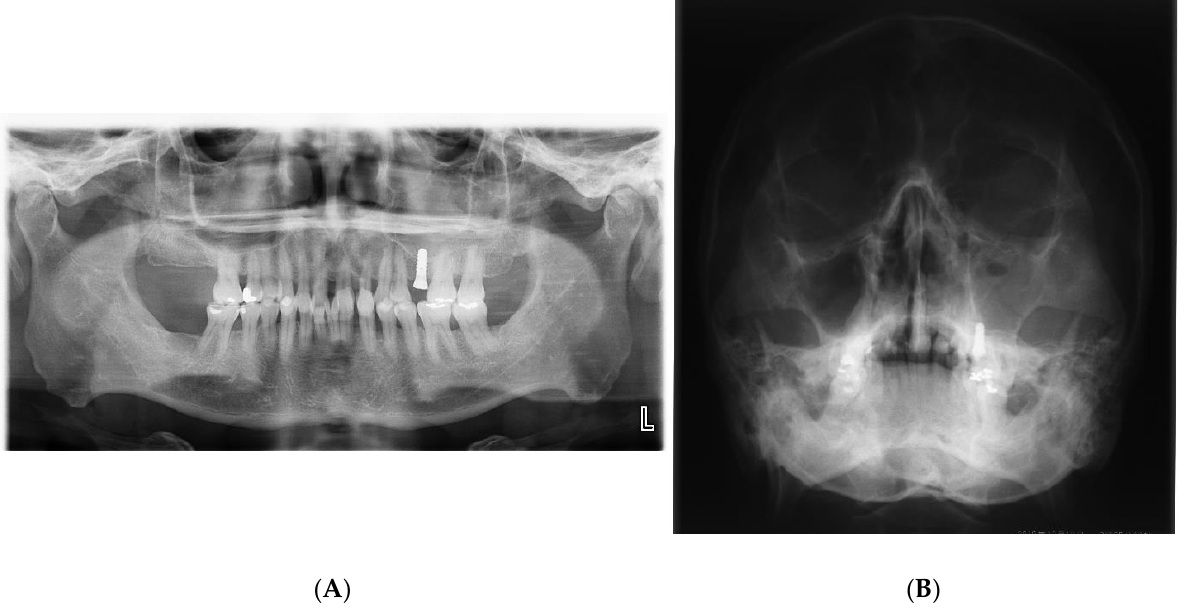
Figure 2. ( A ) During implant placement, the surgeon pierced the maxillary sinus mucosa, and the postoperative panoramic photograph shows that the implant body slightly protrudes into the left maxillary sinus floor; ( B ) 7 days after the operation, the upper left maxillary sinus was opaque, suggesting acute left maxillary sinusitis. (unpublished data)